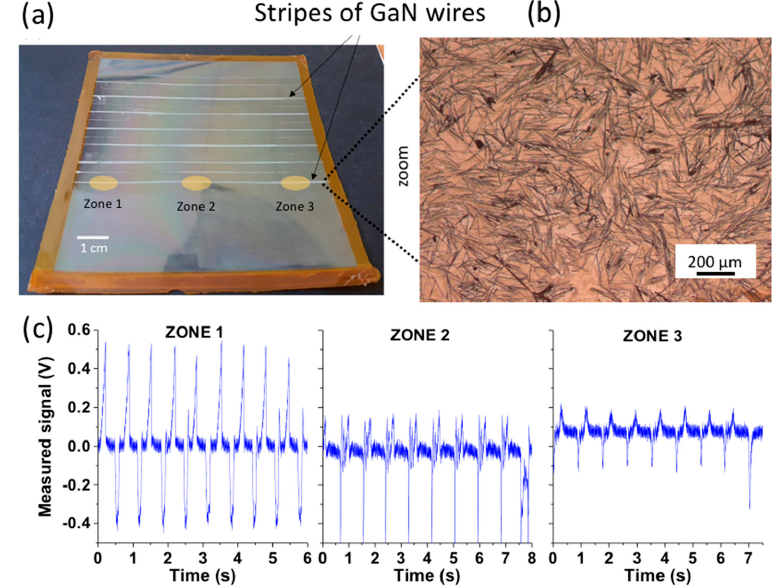
Figure 2. ( a ) Stripes of GaN wires assembled with the Boostream ® process. ( b ) Optical microscopy image of the wires. ( c ) Piezoelectric signal measured on three different regions of a flexible devices made of 104 µm long wires (see Figure 1d). The sensor is subjected to a cycled local compression load/release of 1 N/cm² on 1 cm-diameter disk at the speed of 900 mm/min.